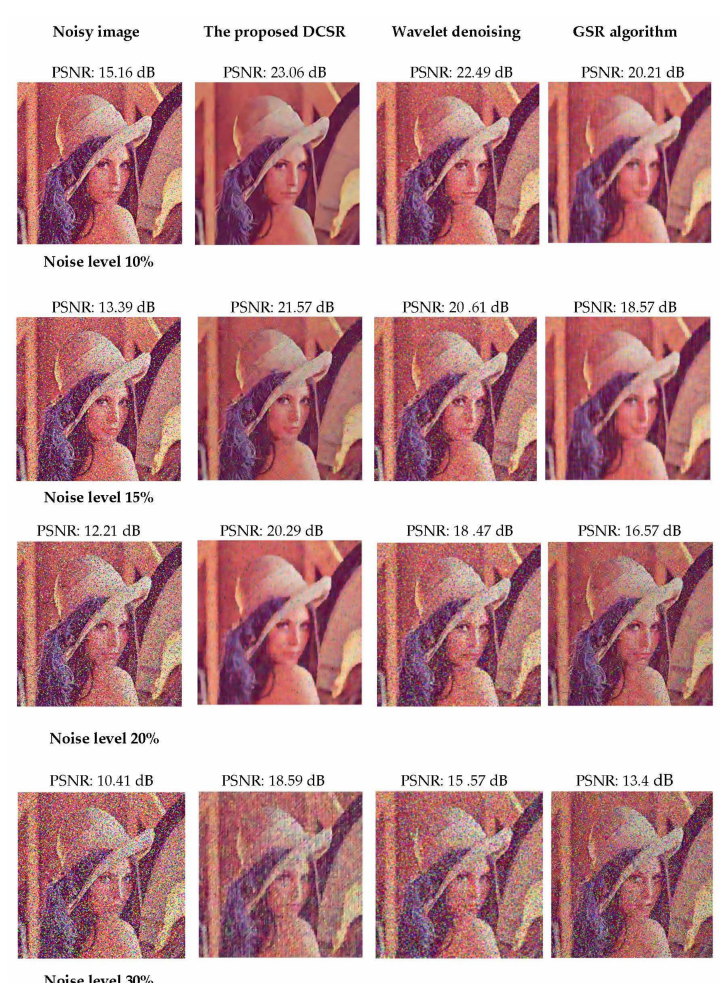
Figure 9. Restoration results of the salt and pepper noise-corrupted Lena image for different values of σ (see column 1 located on the left side of the figure). The algorithms used, the proposed DCSR, wavelet denoising and GSR, are arranged in columns 2, 3 and 4,